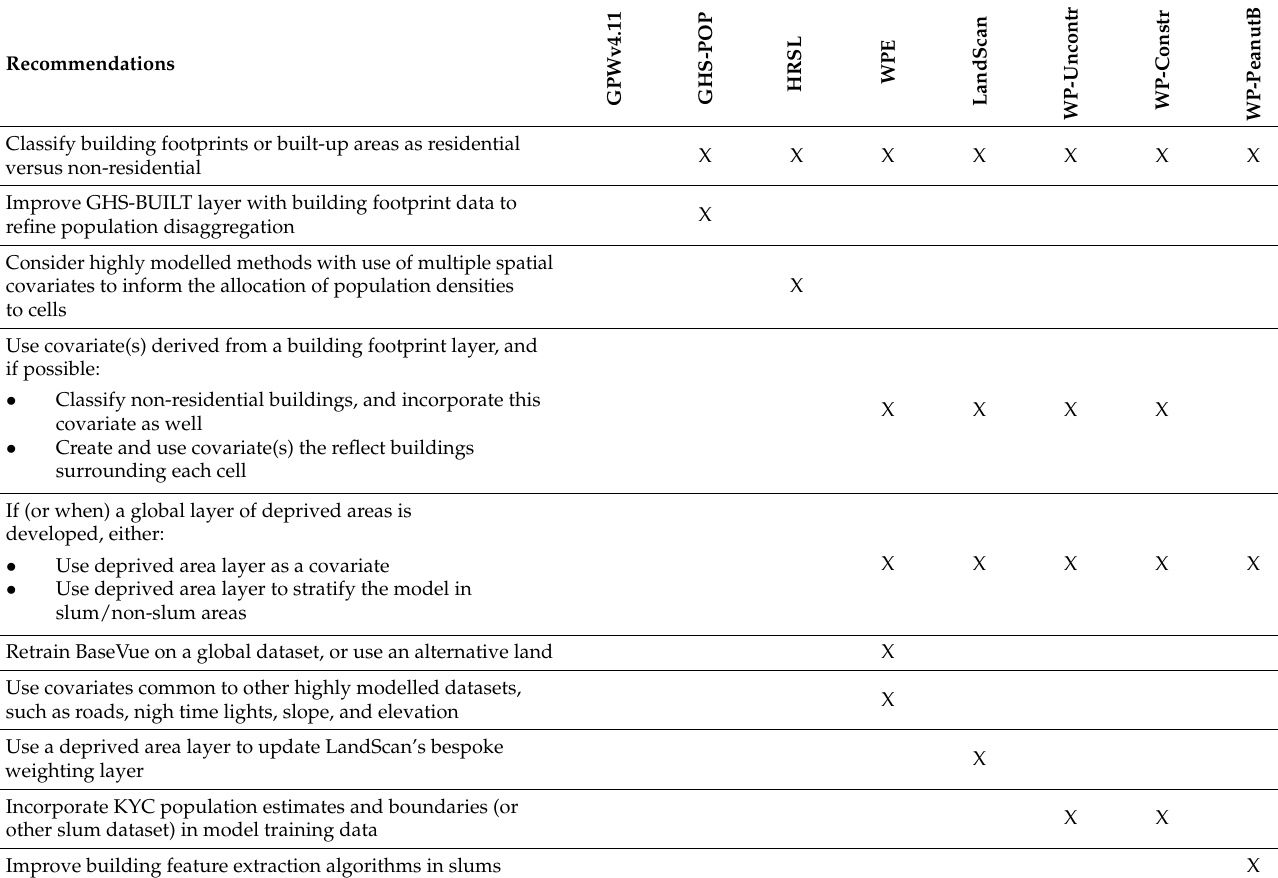
Table 4. Recommendations to potentially improve gridded population estimates in slums and informal settlements.